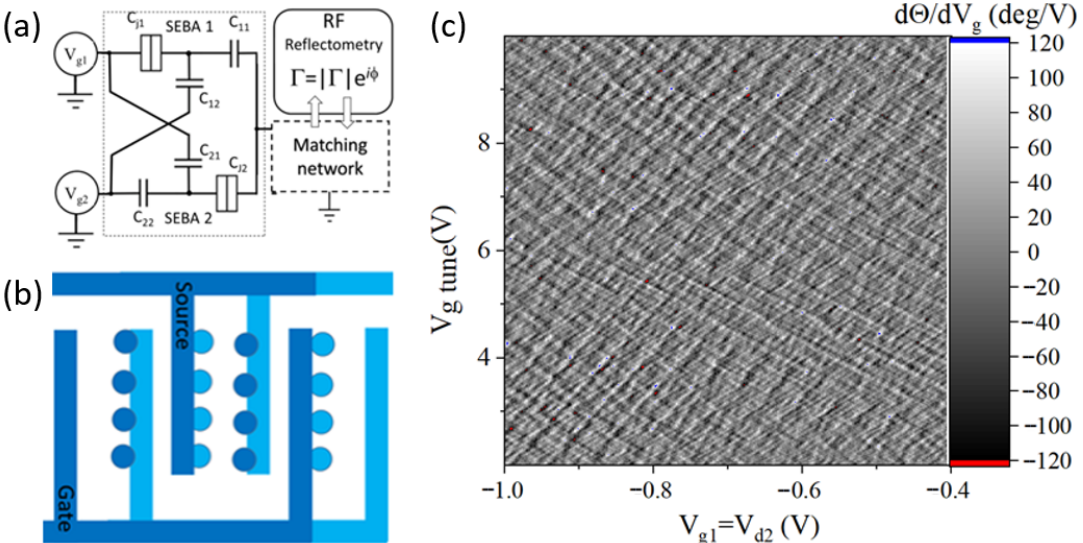
Figure 16. ( a ) Simplified circuit diagram of the counter-parallel connection of SEB arrays. ( b ) A sketch of the design featuring the interdigitated design with alternating placement of islands overlapping either source or gate regions. The different shades of blue represent the two evaporation steps of the Dolan bridge technique. The tuning gate is not shown and it can be placed above or below the structure to ensure dissimilar coupling. ( c ) Experimental 2D map obtained from connecting two nominally identical arrays connected as shown in the circuit diagram. Both arrays nominally contain 200 SEB each.